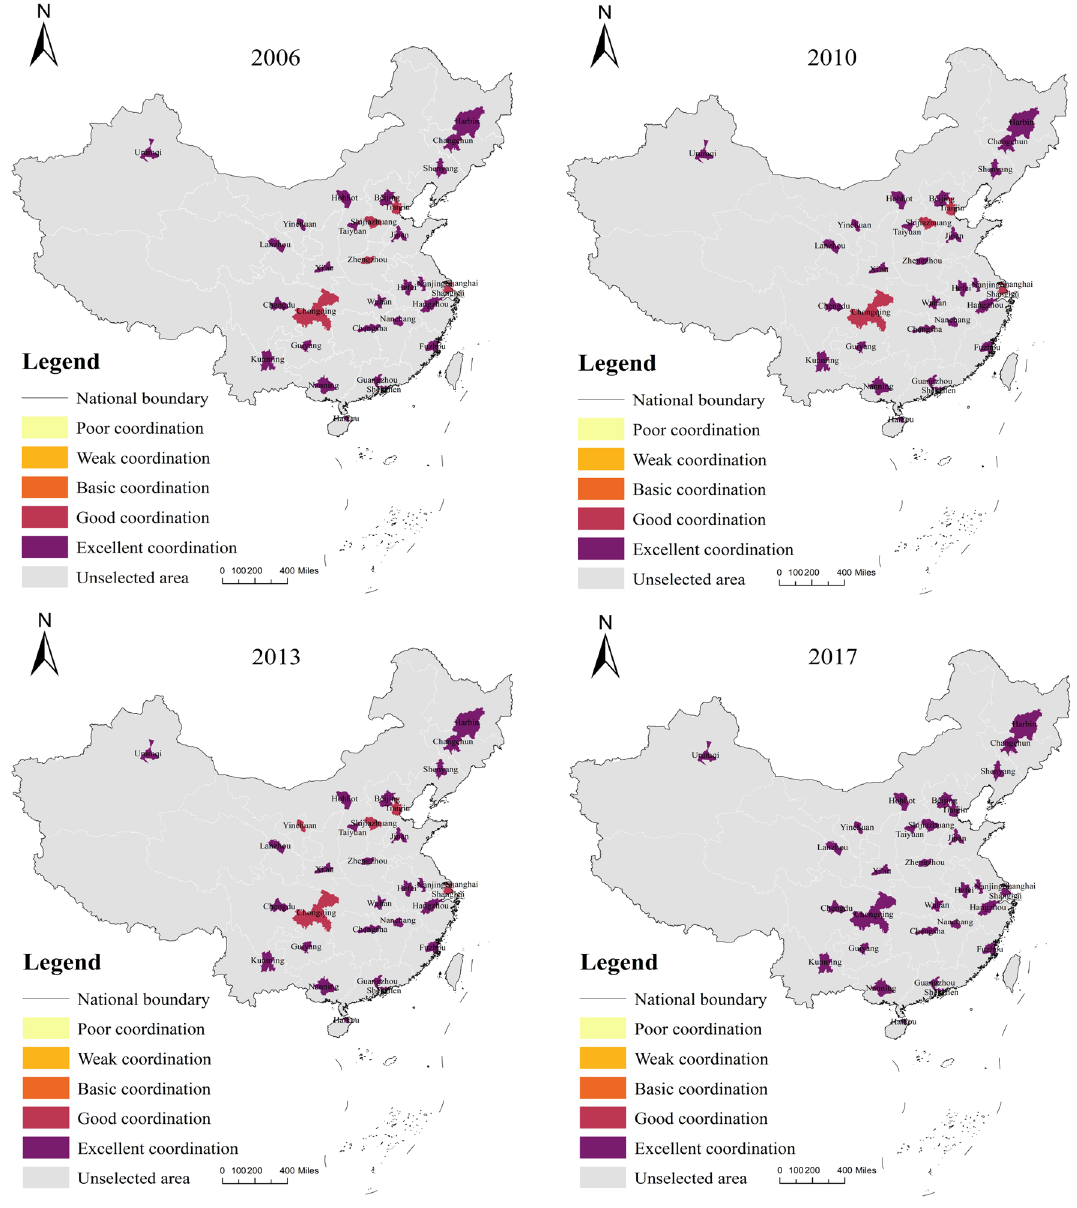
Figure 8. CCD of low-carbon-environment